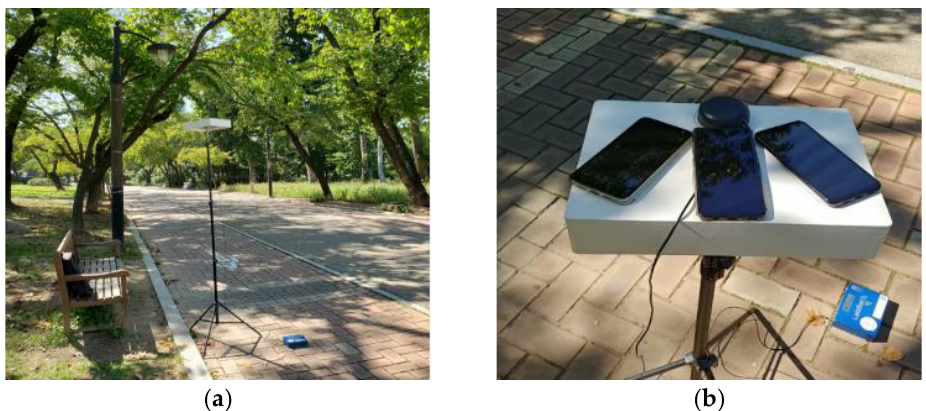
Figure 6. Experiment place: Children’s Grand Park near the Sejong University: ( a ) experimental environment; ( b ) experimental equipment: Android smartphones.